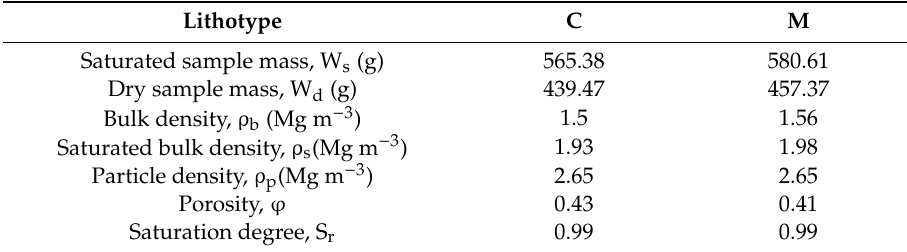
Table 1. Bulk properties of the